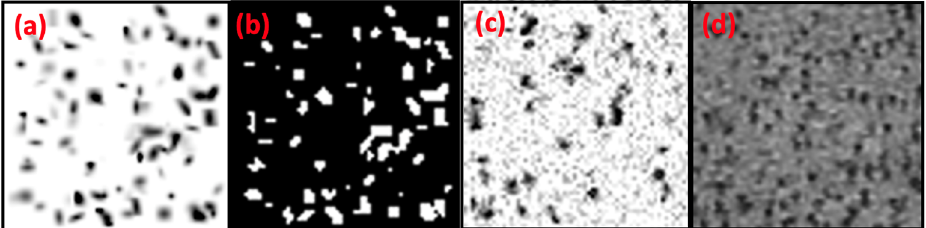
Figure 2. Illustration of training input images of BlobGAN ( a ) Synthesized 3D blobs image from source domain. ( b ) Blob mask of ( a ) from source domain. ( c ) Synthesized 3D noisy blobs image from target domain. ( d ) 3D MR image of the human kidney: patch from target domain.